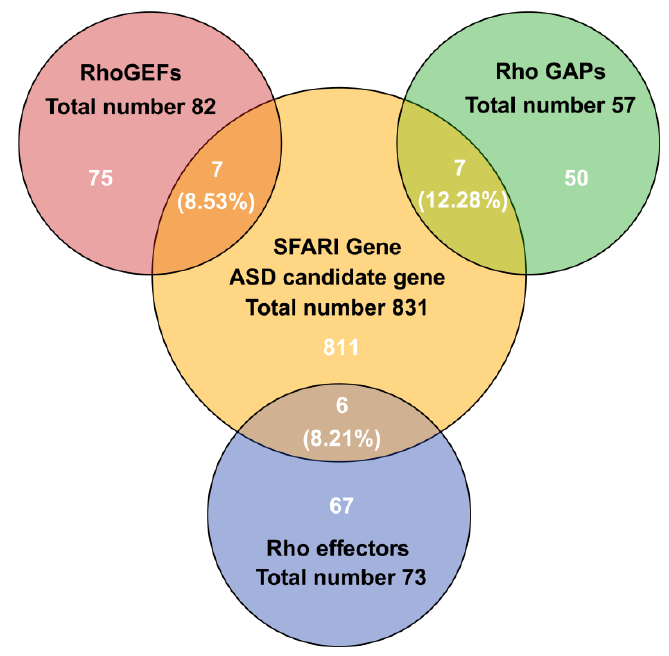
Figure 1. Overlap of human gene sets of RhoGEFs, RhoGAPs, and Rho effectors with autism spectrum disorder (ASD) risk genes in Simons foundation autism research initiative (SFARI). Table 1. Rho family GTPases involved in ASD.